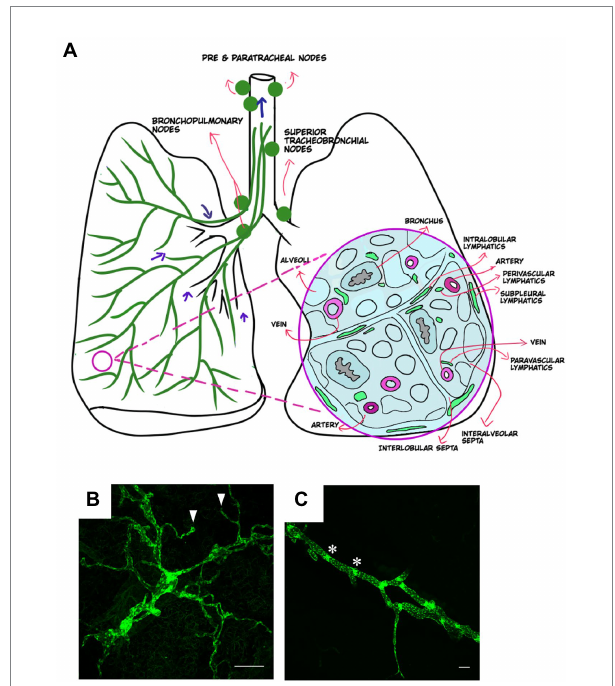
FIGURE 1 Anatomical distribution of lymphatics in healthy lung. (A) Distribution of lymphatics in the lung (green, left) with arrows indicating the direction of lymph flow. Cross section of the lung (right) and the distribution of lymphatics in relation to other lung structures. Images created using MediBang Paint Pro. (B,C) Visualization of lung lymphatics using whole mount immunohistochemistry of lung tissue from a Prox1-EGFP lymphatic reporter mouse, in which all LECs are labeled by GFP expression (green). Initial lymphatics are shown in B , with blunt ends of these vessels indicated by arrowheads. A larger collecting lymphatic is shown in C . Values indicated with asterisks. Scalebars = 50